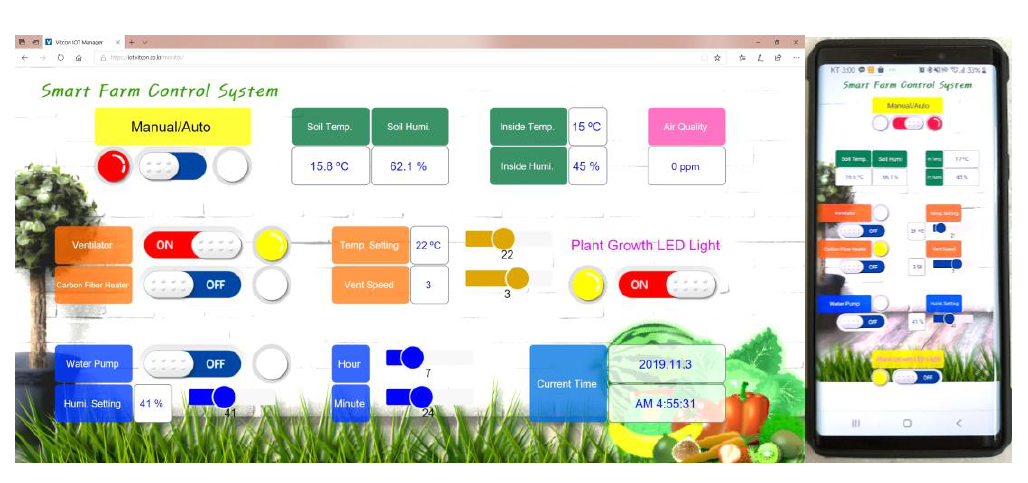
Figure 11. Interface design and block diagram.